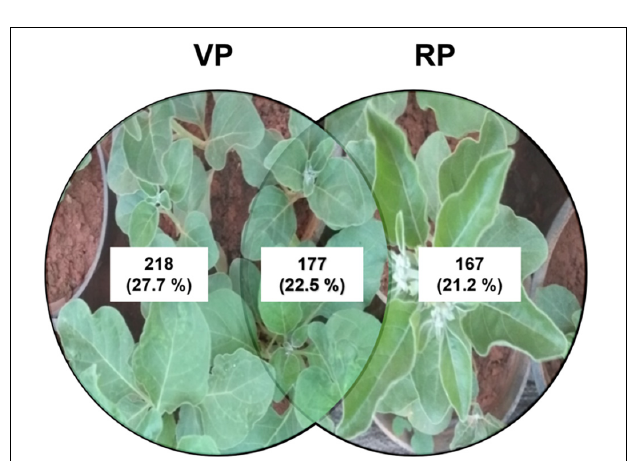
FIGURE 9 | Comparative analysis and distribution of untargeted LC-MS hits of metabolites from VP and RP from whole plant extract of Withania somnifera . The hits were noted and analyzed for its distribution in distinct growth